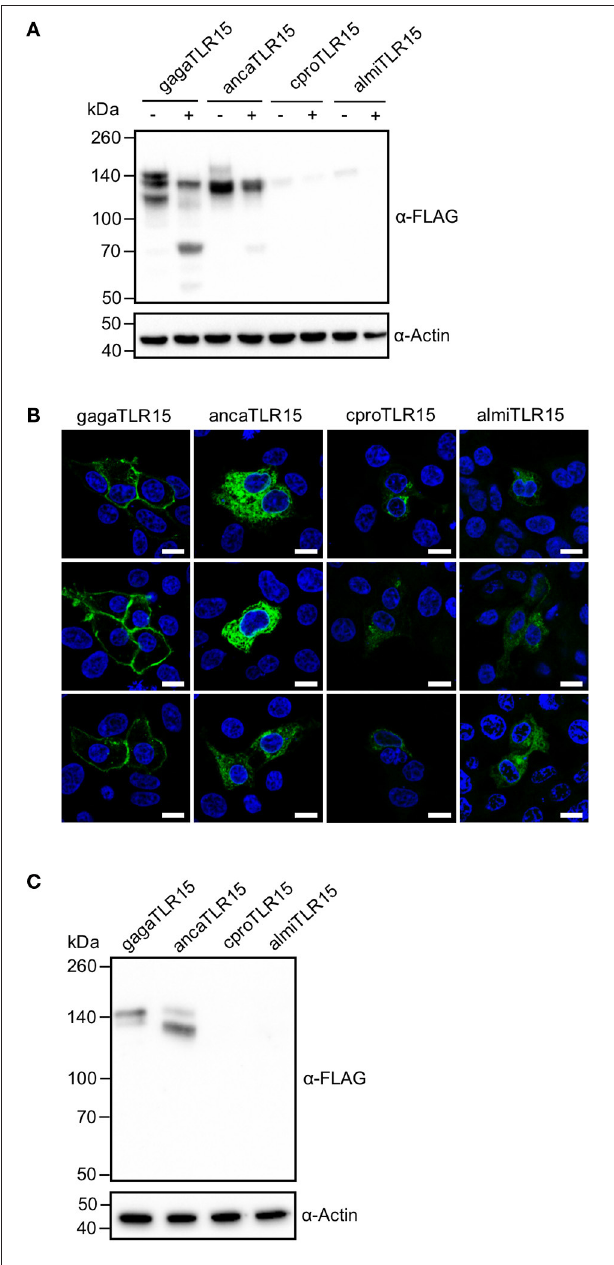
FIGURE 4 | Proteolytic cleavage and expression of reptilian TLR15. (A) Immunoblot analysis of HEK293 cells expressing C-terminally FLAG-tagged chicken (gaga), anolis (anca), crocodile (cpro), or alligator (almi) TLR15 left untreated (–) or stimulated ( + ) (1h) with 250ng/mL Proteinase K. Mature TLR15 is ∼ 140 kDa. Treatment with Proteinase K results in cleavage of gagaTLR15 and ancaTLR15 to form a cleaved receptor fragment that is slightly higher than 70 kDa. Note that crpoTLR15 and almiTLR15 are poorly expressed compared to ancaTLR15 and gagaTLR15. Beta-actin was detected to confirm equal loading of total protein onto SDS-PAGE gel. (B) Confocal microscopy on HEK293 cells expressing C-terminally HA-tagged TLR15 (green). Note that crpoTLR15 and almiTLR15 show lower expression compared to ancaTLR15 and gagaTLR15. All images were produced with the same microscopy settings. Nuclei are stained with DAPI (blue). White scale bar (Continued)